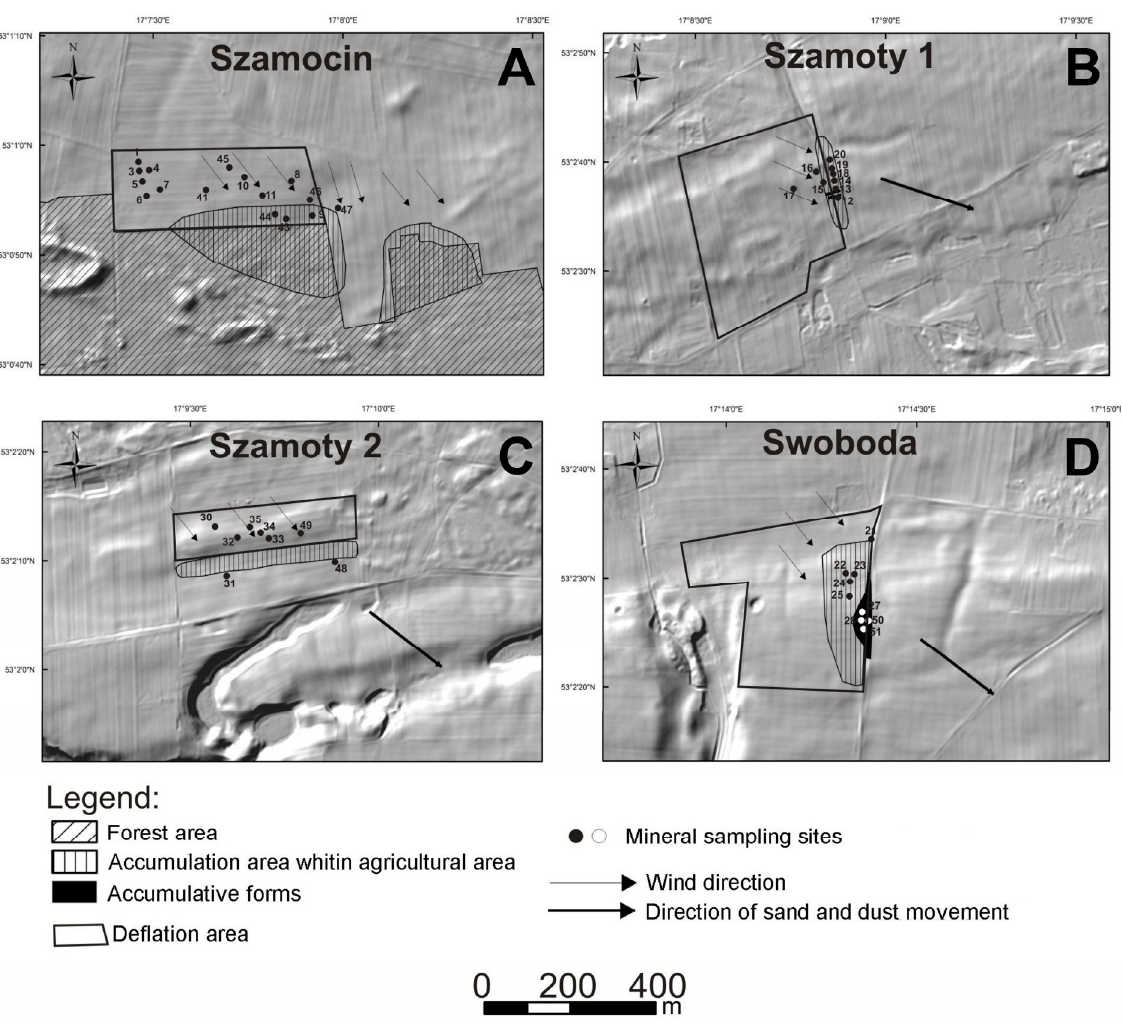
Figure 6. Covers and accumulative forms in respective research areas: ( A )—Szamocin, ( B )—Szamoty 1, ( C )—Szamoty 2, ( D )—Swoboda. Ranges of covers and accumulative forms were determined based on GPS RTK (Real Time Kinematics) measurements.